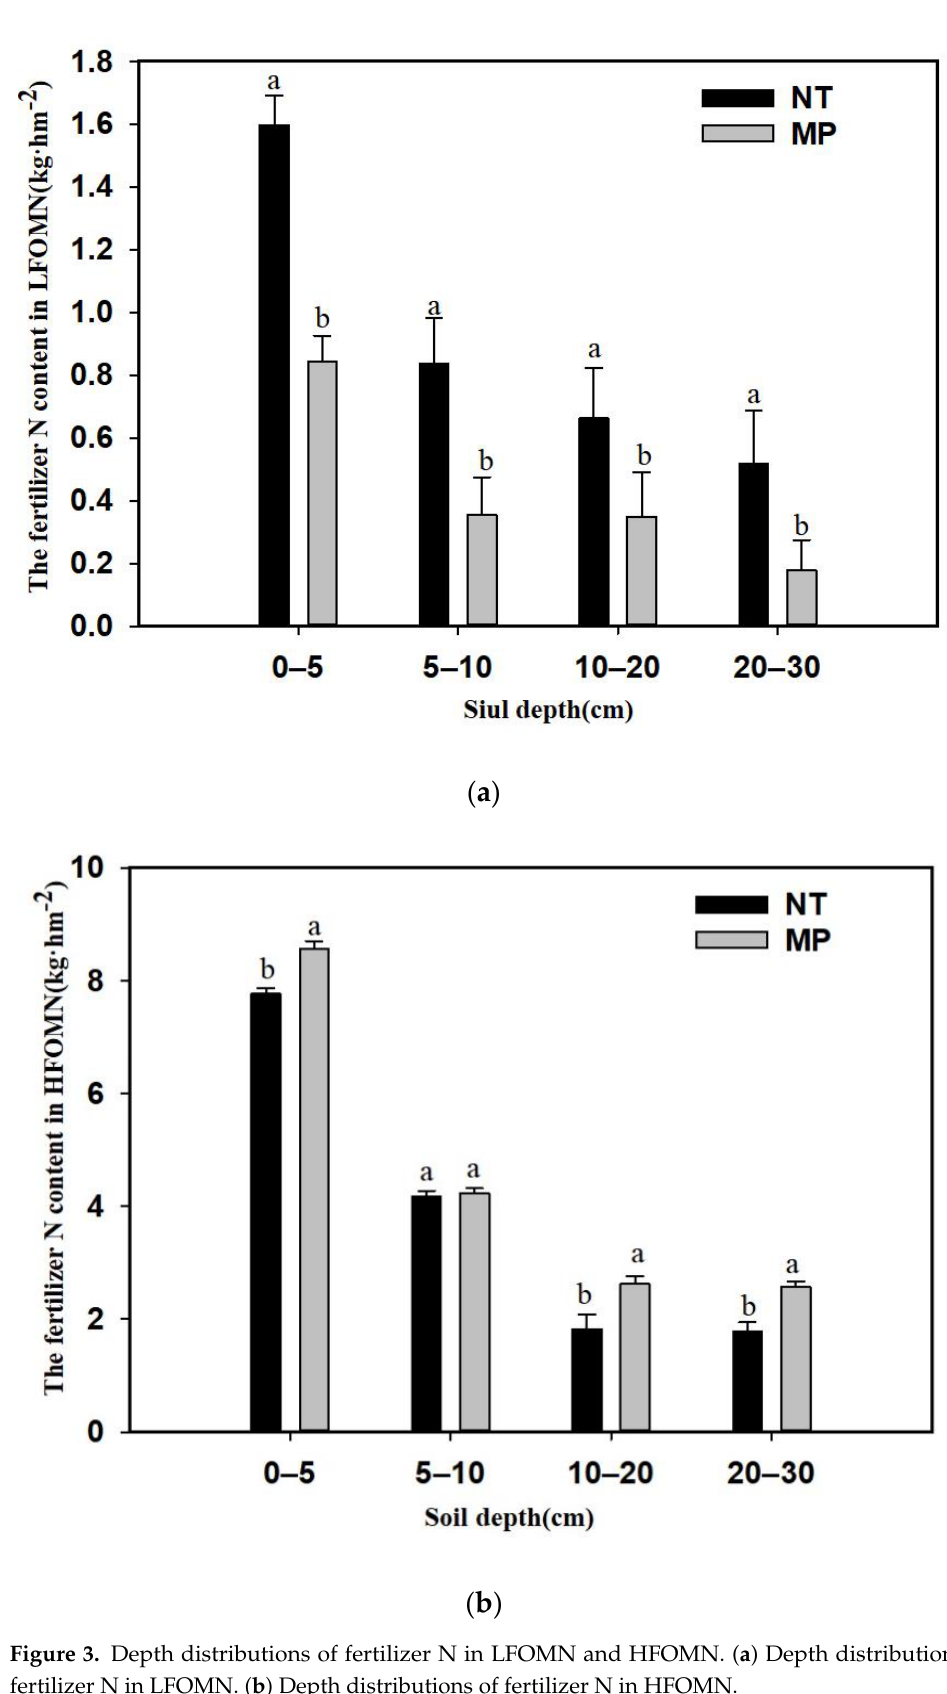
Figure 3. Depth distributions of fertilizer N in LFOMN and HFOMN. ( a ) Depth distributions of fertilizer N in LFOMN. ( b ) Depth distributions of fertilizer N in HFOMN.